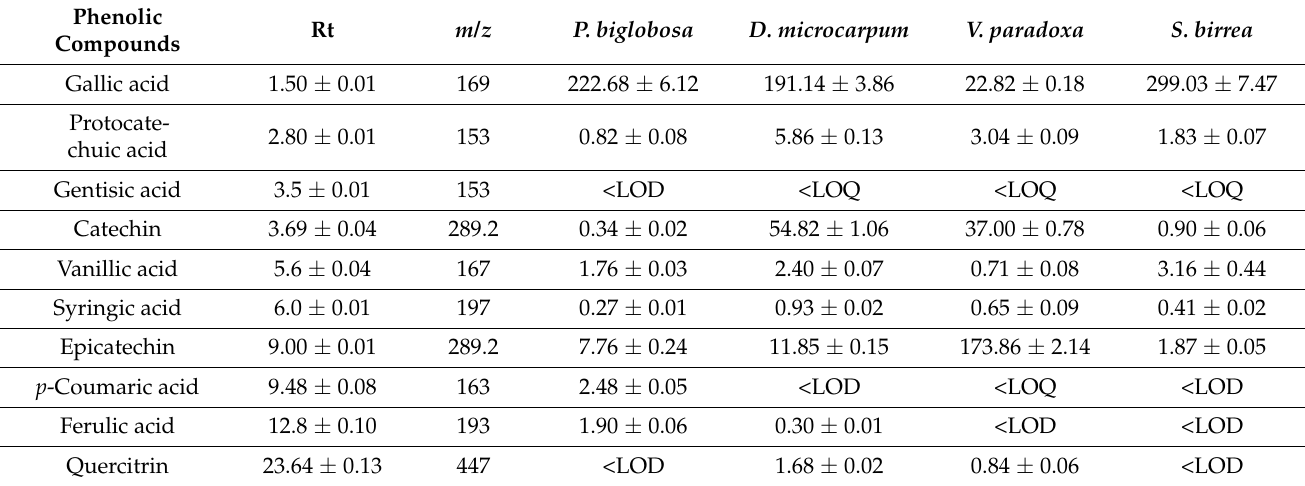
Table 1. Phenolic compounds identified in the extracts (mg/100g extract).